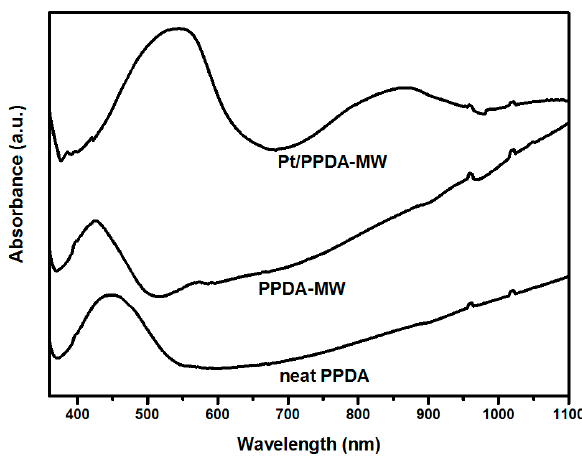
Figure 4. UV-VIS spectra of neat PPDA, PPDA-MW, and Pt/PPDA-MW.